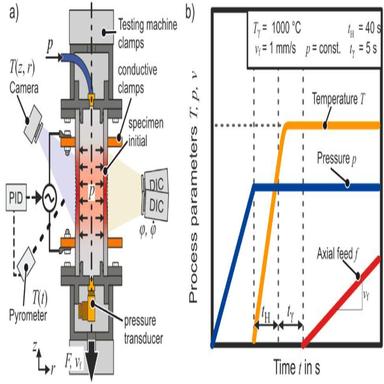
a) Experimental set-up for the PTT-test and b) aspired profiles of the process variables temperature T, pressure p and axial feed v over time.